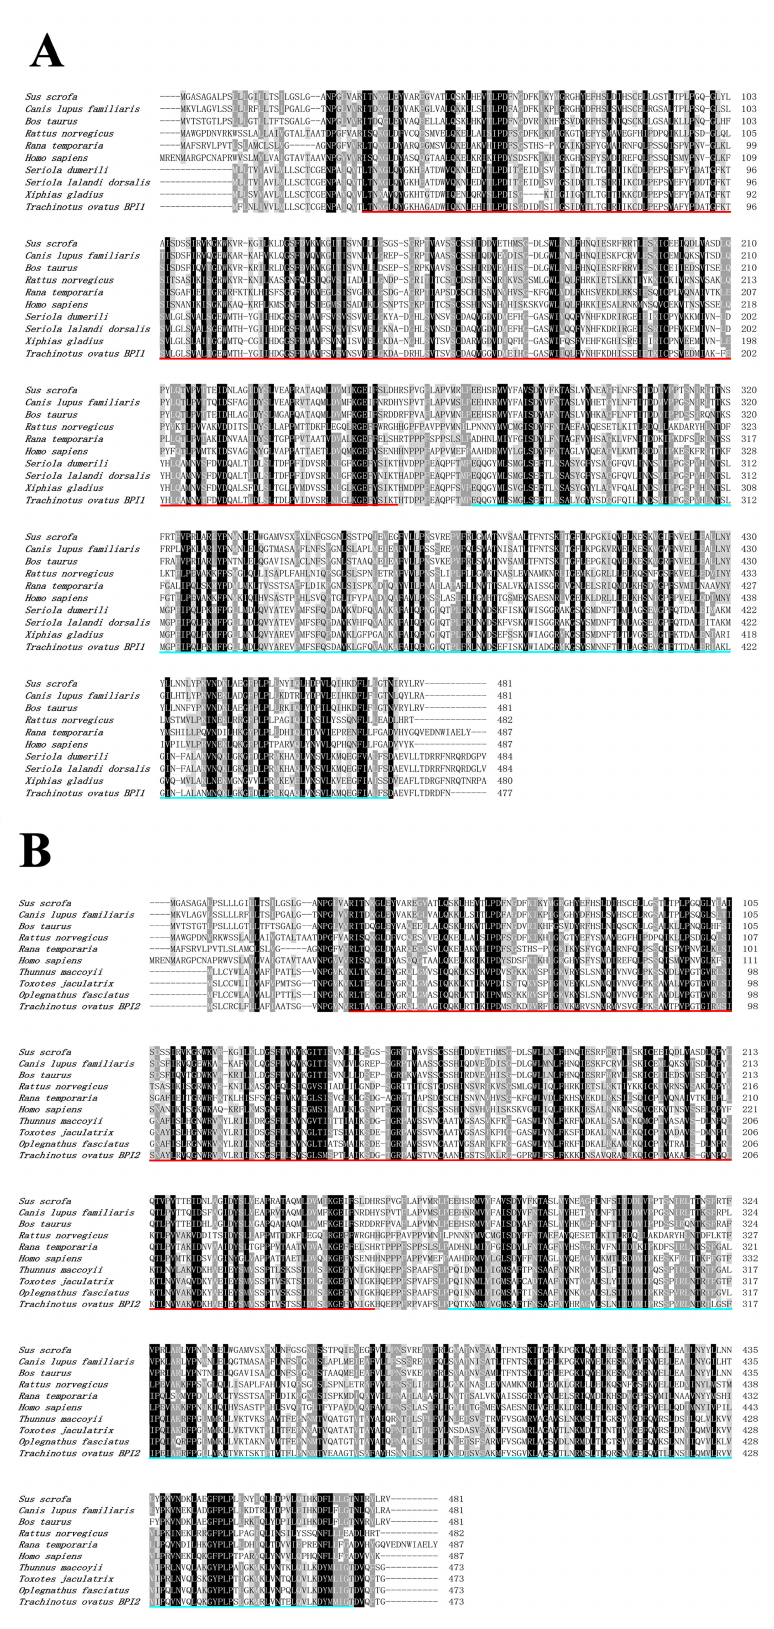
Figure 2. Comparison of ToBPI1/LBP ( A ) and ToBPI2/LBP ( B ) with the homologous sequences of BPI/LBP. The black part at the bottom has the same sequence, and the grey part has high repeatability. The N-terminal domains are represented by red lines and C-terminal domains by blue